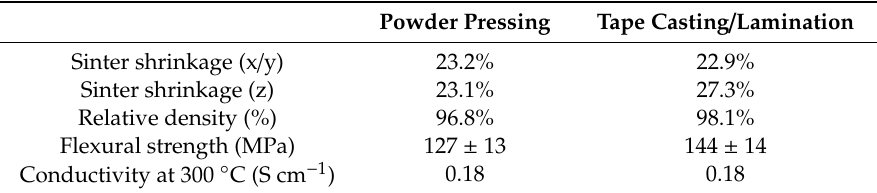
Table 2. Comparison of properties of Na- β ”Al 2 O 3 ceramics formed by uniaxial pressing of powder versus those prepared by tape casting and lamination. Sintering conditions were 1600 ◦ C for 5 min in all